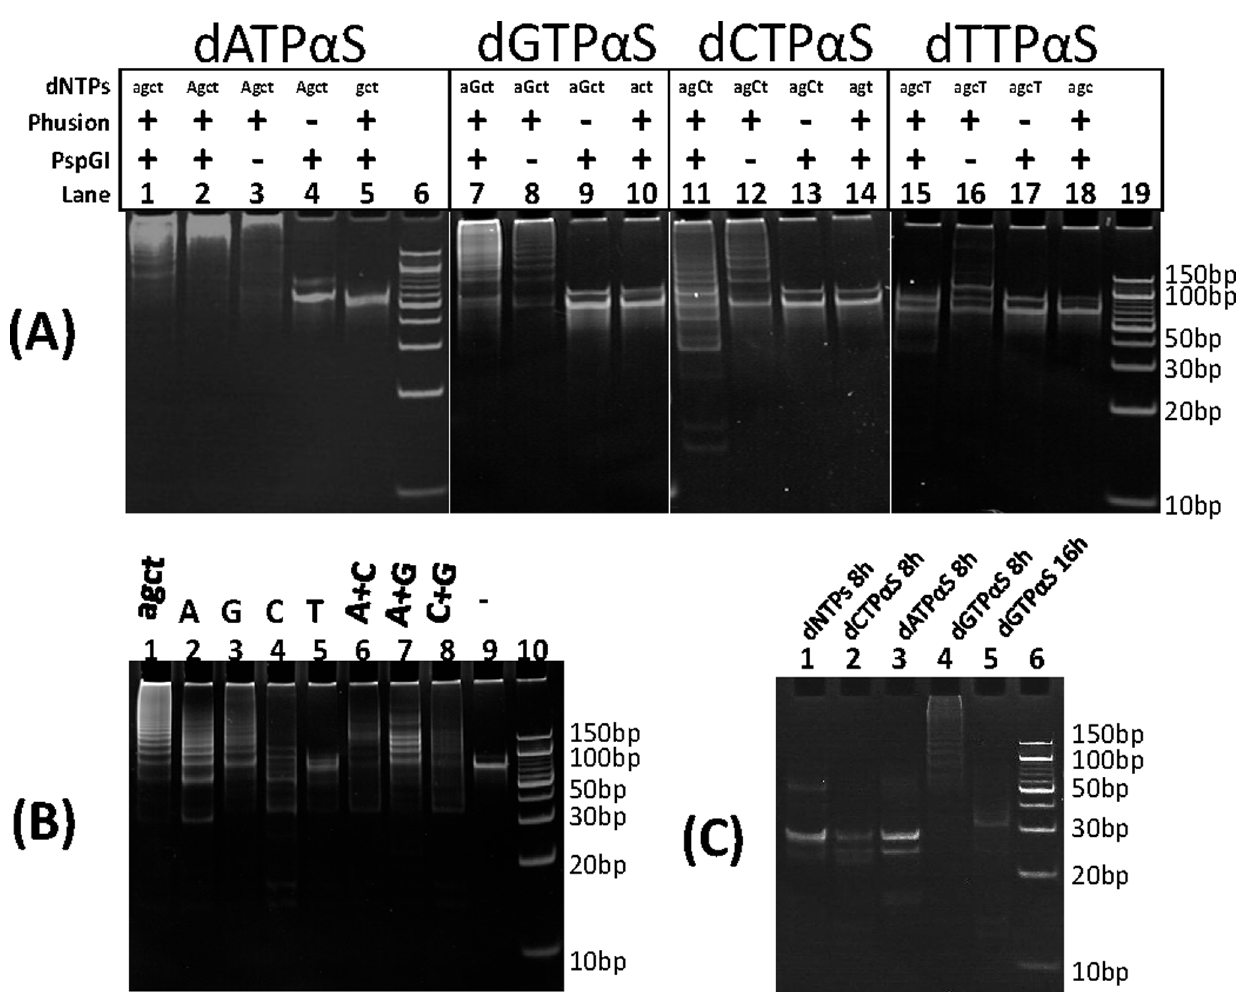
Figure 2. PAGE electrophoresis of PEAR products. For dNTPs, lowercase letters (agct) represents natural dNTPs, and uppercase letters (AGCT) represents dNTP a Ss. (A) PEAR products incorporating natural or dATP a S, dGTP a S, dCTP a S, dTTP a S: Lane 1: natural dNTPs; Lane 2: dATP a Ss; Lane 3: No PspGI control; Lane 4: No Phusion DNA polymerase control; Lane 5: No dATP control; Lane 6:10bp DNA ladder; Lane 7: dGTP a S; Lane 8: No PspGI control; Lane 9: No Phusion DNA polymerase control; Lane 10: No dCTP control; Lane 11: dCTP a Ss; Lane 12: No PspGI control; Lane 13: No Phusion DNA polymerase control; Lane 14: No dCTP control; Lane 15: dTTP a Ss; Lane 16: No PspGI control; Lane 17: No Phusion DNA polymerase control; Lane 18: No dTTP control; Lane 19:10bp DNA ladder. (B) PEAR products incorporating one or two kind of dNTP a Ss: Lane 1: natural dNTPs; Lane 2–5: one kind of dNTP a Ss; Lane 6–8: two kind of dNTP a Ss; Lane 9: No dNTPs control; Lane 10:10bp DNA ladder; (C) Full digestion of PEAR products incorporating different dNTPs or dNTP a